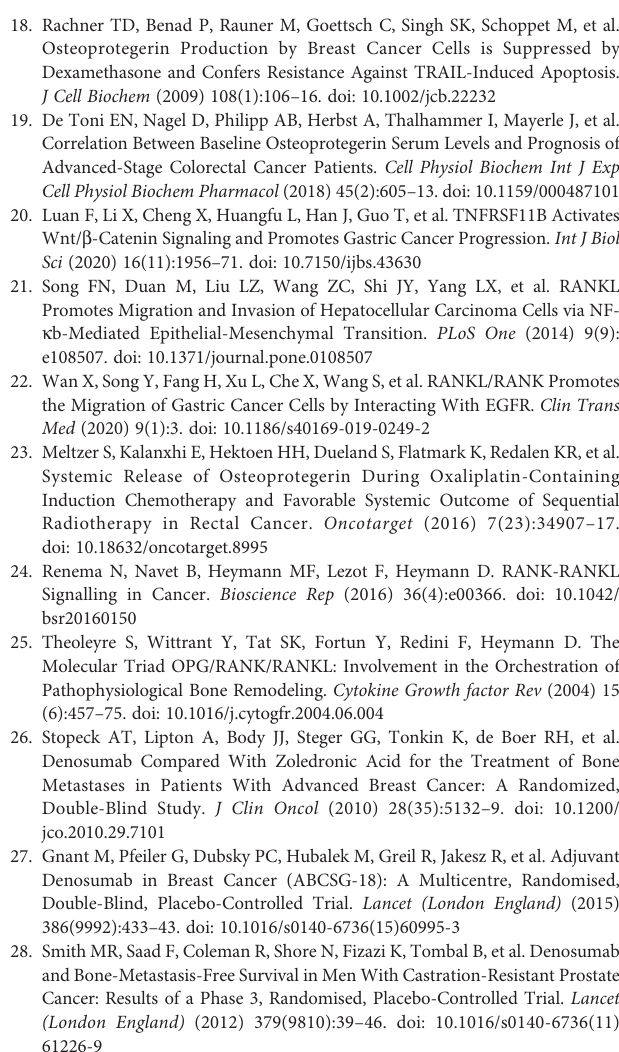
Supplementary Figure 1 | Forest plot showing the effect of serum OPG levels on overall survival in HCC patients strati fi ed by different clinicopathological factors after matching. HR>1 and p<0.05 suggested that higher OPG levels in serum were associated with poorer survival outcome.